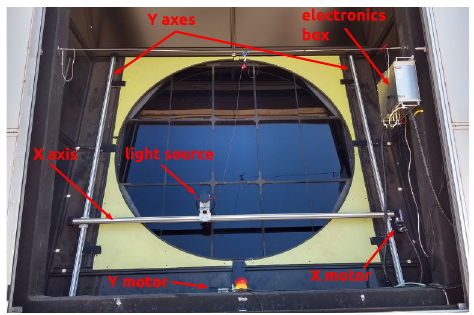
Figure 3. Photo of an FD telescope aperture with fully installed XY-Scanner. The Y axes and Y motor are permanently mounted at the aperture while the X axis with X motor, light source, and electronics box are